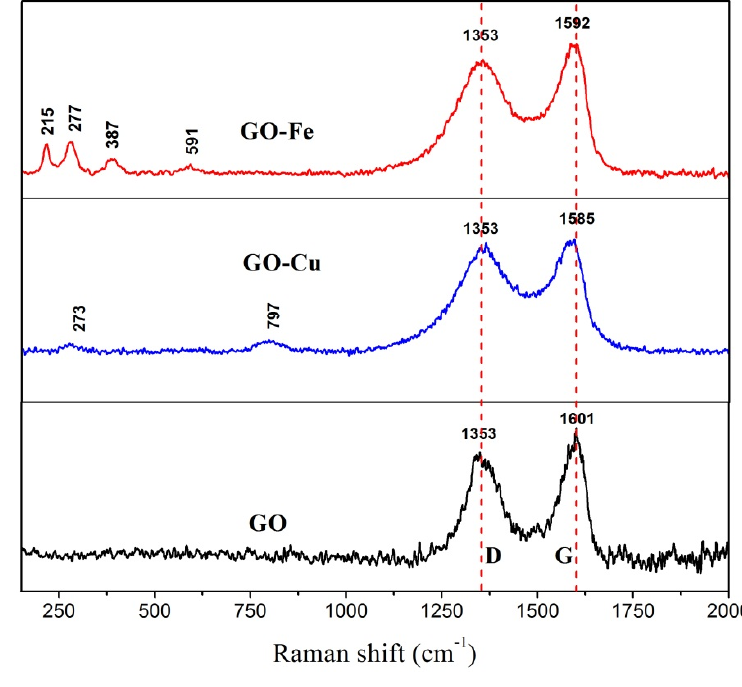
Figure 2. Raman spectra of nGO, nGO-Cu, and nGO-Fe.